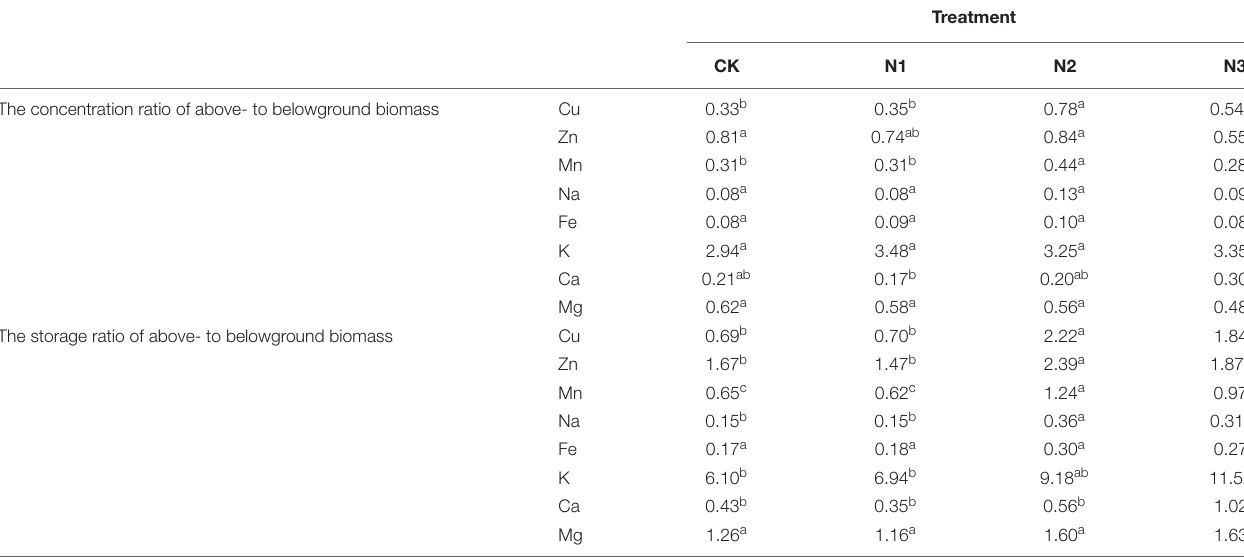
TABLE 2 | The concentration and storage ratios of above- to belowground biomass macro- and micronutrient of B. ischaemum in each treatment.